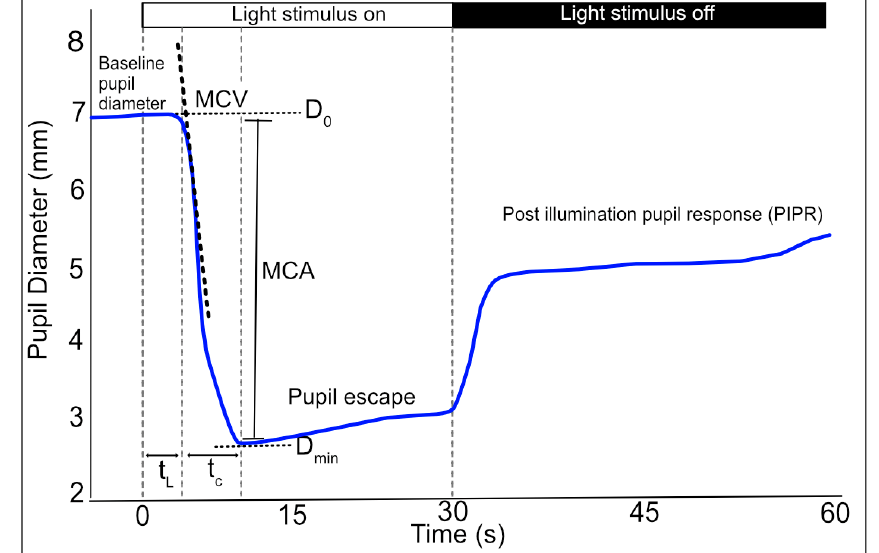
Figure 1. Schematic of the pupillogram (blue line) and associated PLR parameters. The light stimulus at time zero results in a rapid reduction in pupil diameter. Latency (t L ) is calculated as the elapsed time between light onset and the start of constriction. The pupil then rapidly constricts (maximal constriction velocity; MCV) from the baseline (D 0 ) pupil diameter to the minimum (D min ) pupil diameter; the constriction time (t C ) and maximum constriction amplitude (MCA) are calculated as the time interval and size difference between these two values, respectively. At offset of light stimulus or during sustained light stimulation the pupil undergoes a period of rapid redilation or pupillary “escape” to a partially constricted state. Subsequently the pupil slowly returns to the baseline diameter.